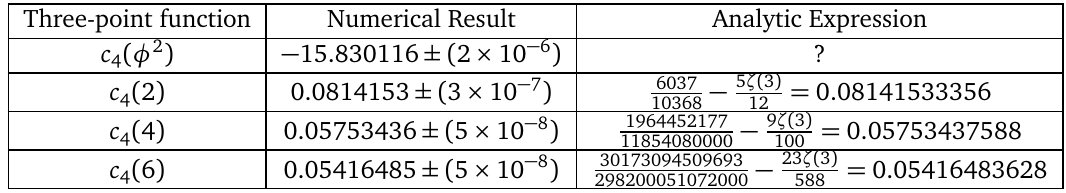
Table 3: Numerical and analytic results for the three-point functions of the twist two operators and φ 2 at order g 4